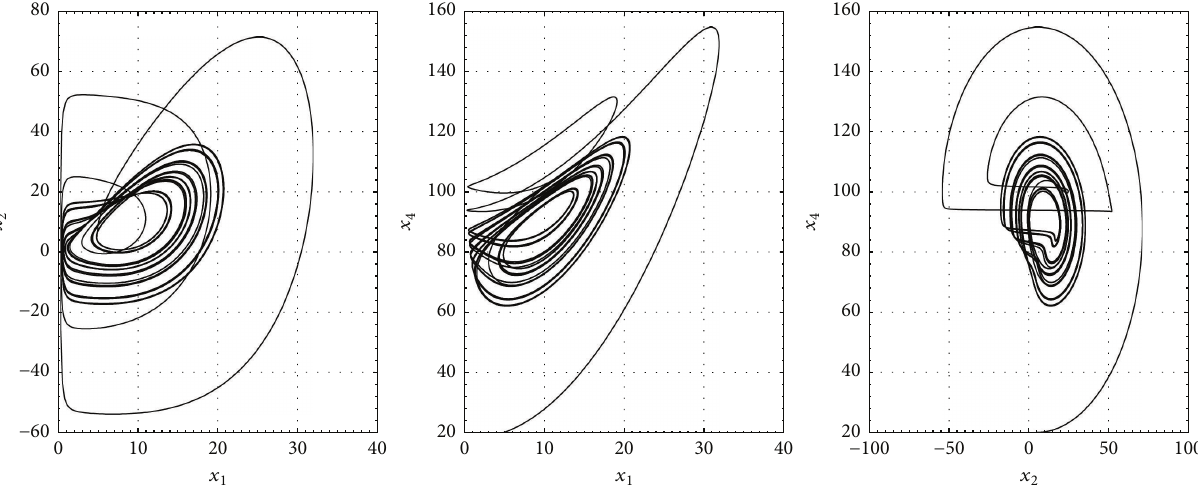
Figure 4: Phase space of the hyperchaotic Lorenz-Haken system (17).